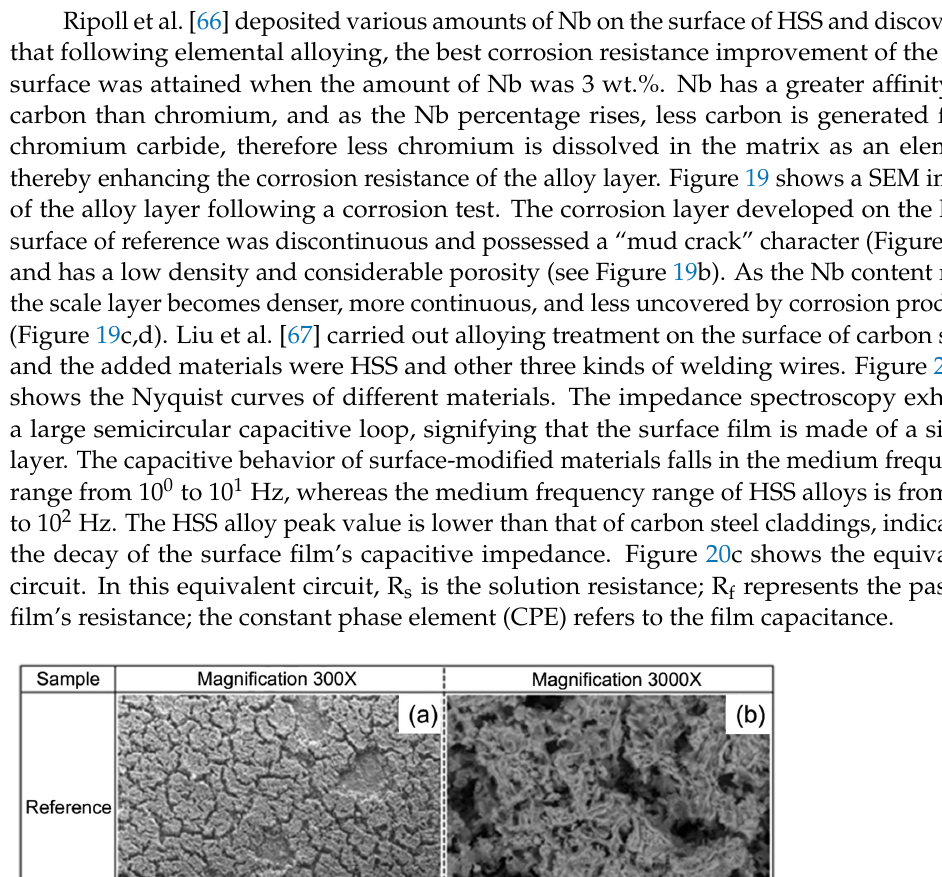
Figure 20. ( a ) Nyquist curves of HSS and different carbon steel claddings; ( b ) phase angle of HSS and different carbon steel claddings; ( c ) Schematic of tested materials [67]. 5. Summary and Outlook Since its invention, HSS has expanded swiftly into a wide variety of forms, and is currently undergoing a period of sustained growth. Changing the ratio of metal elements in HSS has limited effect, and it is difficult to match the growing demand. Because of its low material demand and stronger surface requirements, high-energy beam surface strengthening technology has become increasingly attractive for further strengthening HSS surface properties. Due to the fact that it only remelts the surface of HSS substrates, high-energy beam remelting technology offers a moderate performance increase econom- ically and effectively. Furthermore, by utilizing the superior performance of HSS